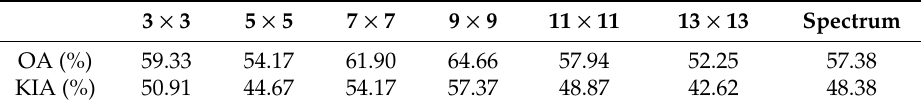
Table 10. The OA and KIA of urban vegetation types classification in